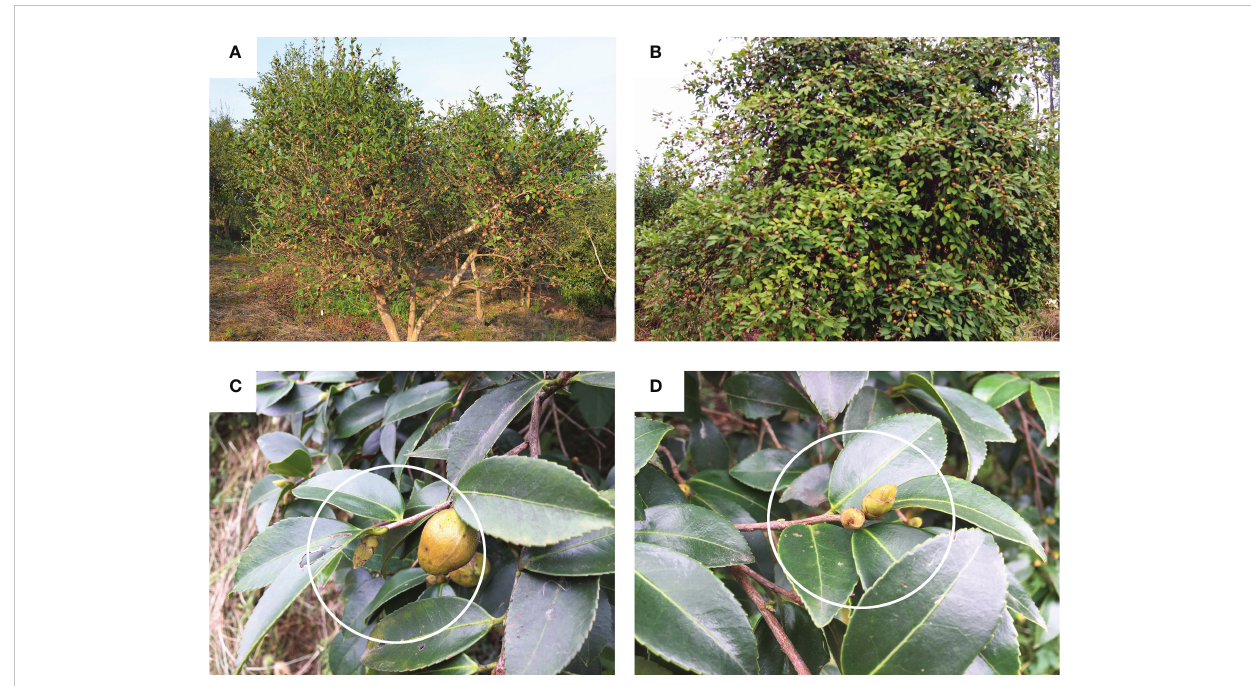
FIGURE 1 Observation on fl ower buds and fruits of two Camellia oleifera cultivars. A : MY3; B : QY2; C : QY2 in productive year; D : QY2 in poor harvest